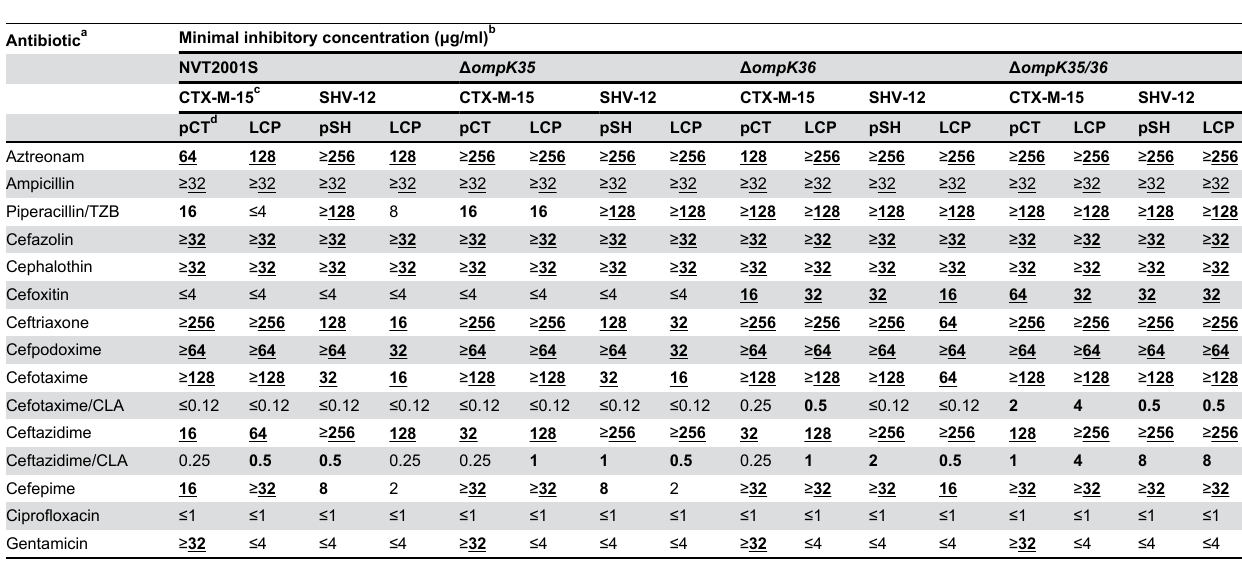
Table 3. MICs of antibiotics against K. pneumoniae NVT2001S and its porin-loss mutants with extended-spectrum β-